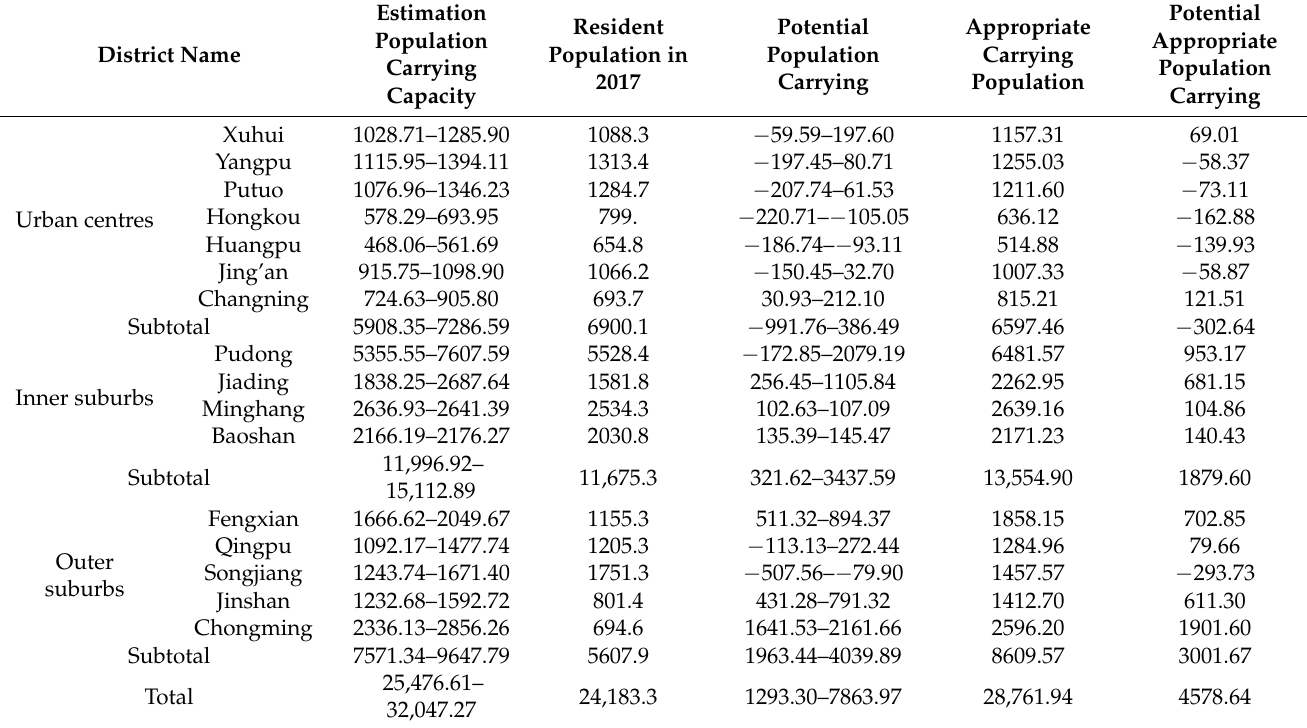
Table 9. Population carrying capacity and potential of each district in Shanghai (thousand